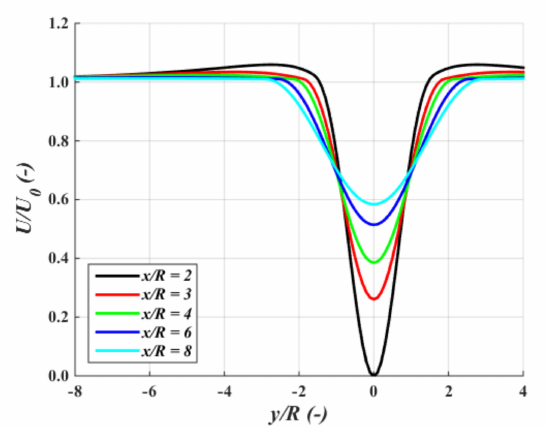
Figure 2. Tower wake wind speed distribution according to Moriarty’s model, C d = 1.2.